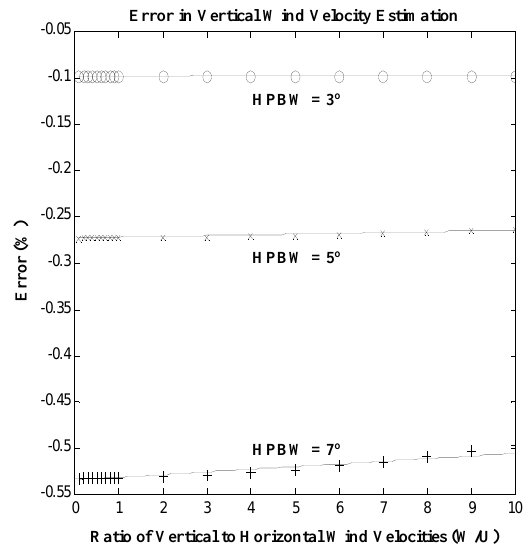
Fig. 6. Comparison between beam broadening spectrum (solid curve) obtained by numerically integrating radar power along the contours of radial velocity and a Gaussian spectrum (dashed curve) with a spectral width of 0.0371ms − 1 (corresponding to 1ms − 1 of horizontal wind velocity for a 52-MHz antenna beam with 5 ◦ width), in which V m and σ m are, respectively, estimated mean Doppler velocity and spectral width of the exact beam broadening spectrum by means of the moment method.